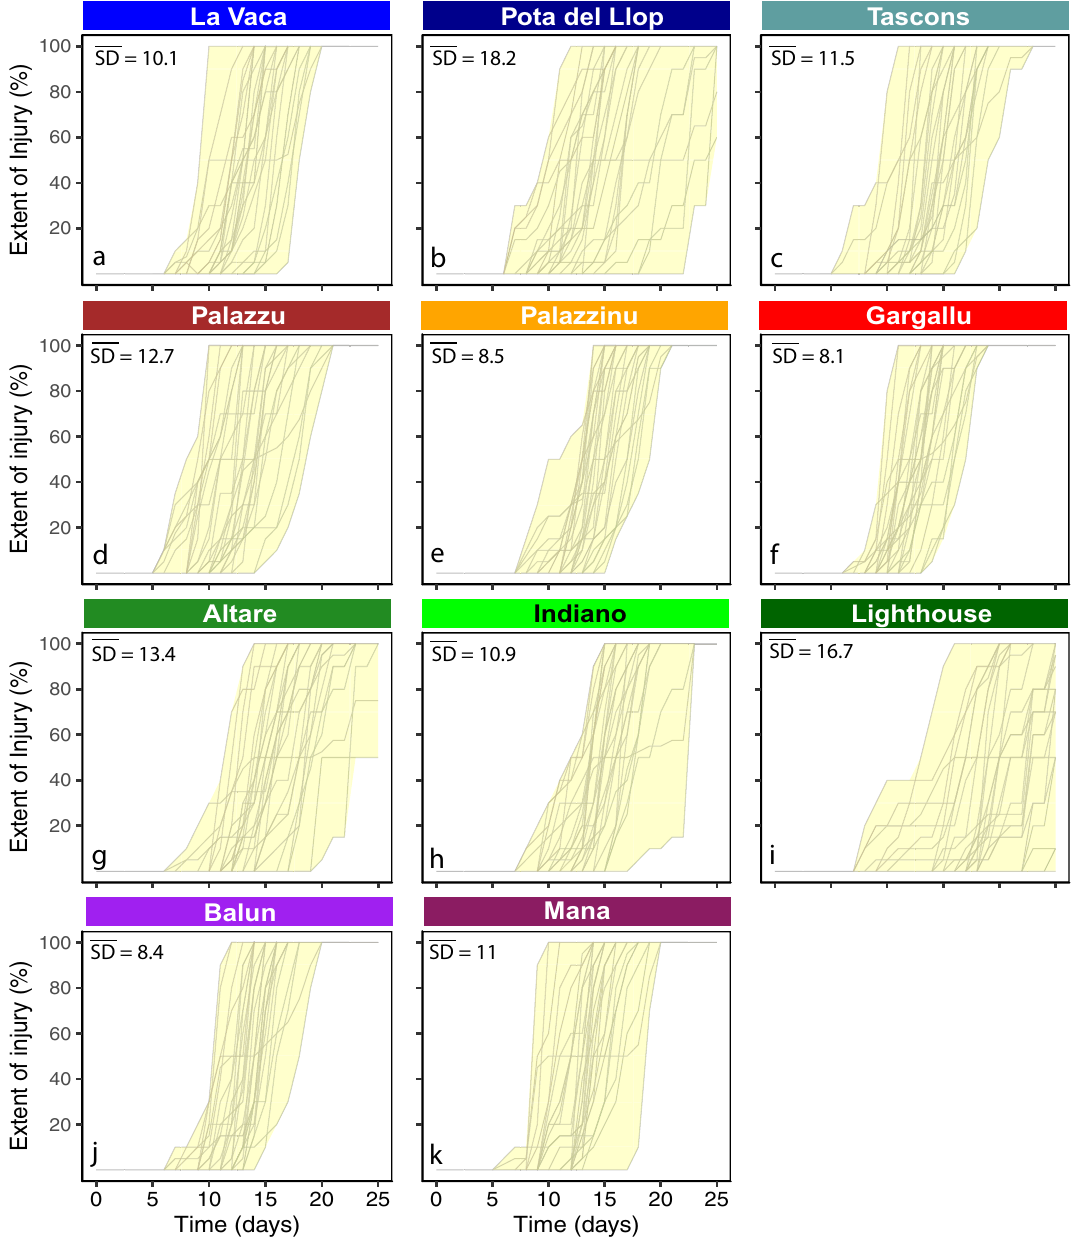
Figure 5. Intra-population variability observed in P. clavata populations exposed to heat stress. The response curve of each colony is shown in grey for each population (( a – c ) Medes, ( d – f ) Scandola, ( g – i ) Portofino and ( j – k ) Kornati). A yellow ribbon has been added to visualize the overall variability in the population (encompassing the temporal span between the most resistant colony and the most sensitive colony). The mean daily SD of extent of injury among colonies calculated across the 25 days of the experiment is also shown for each